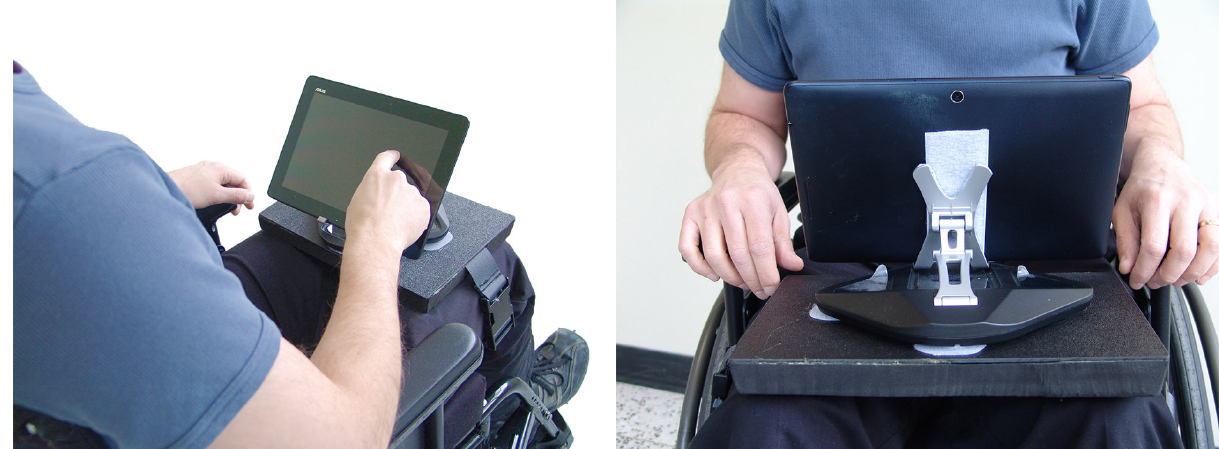
Figure 2. Tablet and mounting platform for in-chair